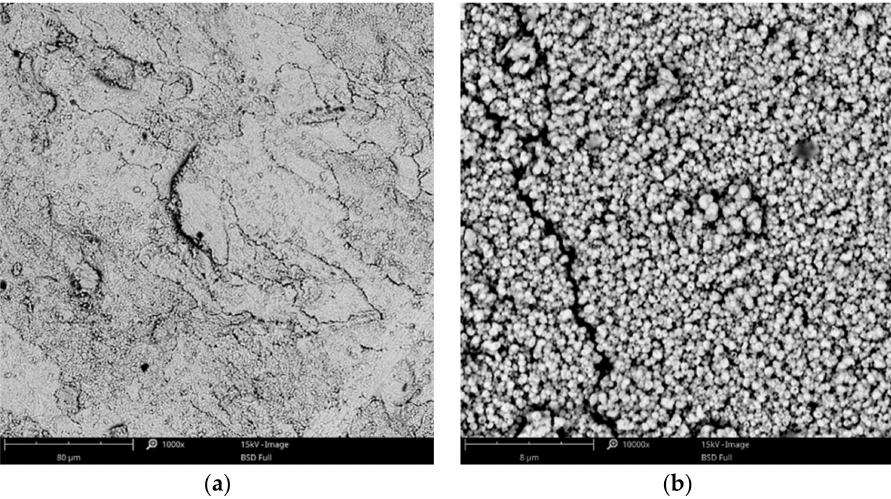
Figure 4. SEM images of the Cu coating electrodeposited in the bath with 60 g · L − 1 of CuAc at a temperature of 75 ◦ C (j c = 12 mA · cm − 2 , t = 7.5 min) at low ( a ) and high ( b )